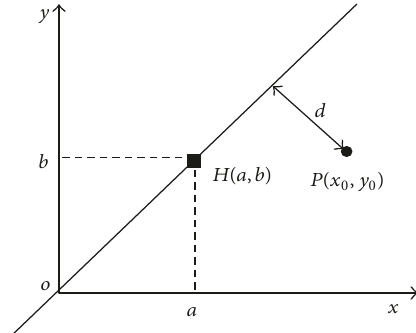
Figure 2: Distance of point to line 2D objective space.